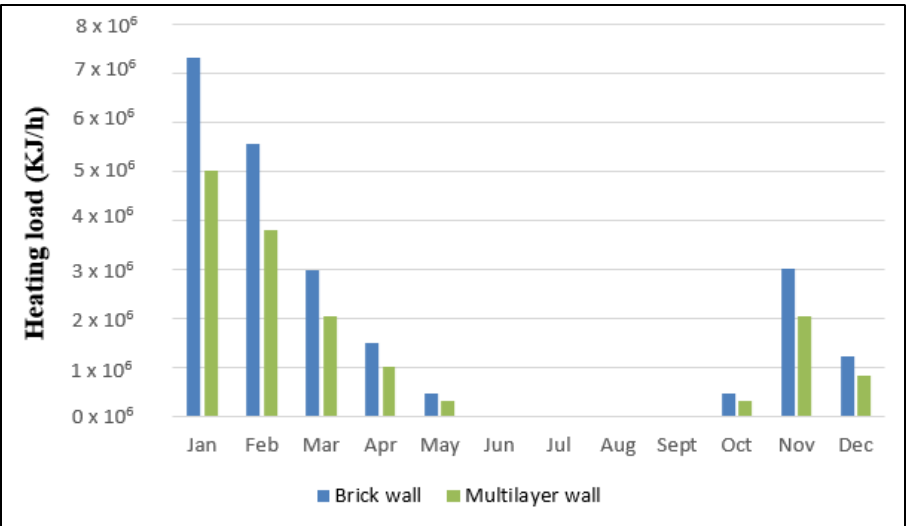
Figure 4. Monthly heating needs for the simulated configurations.